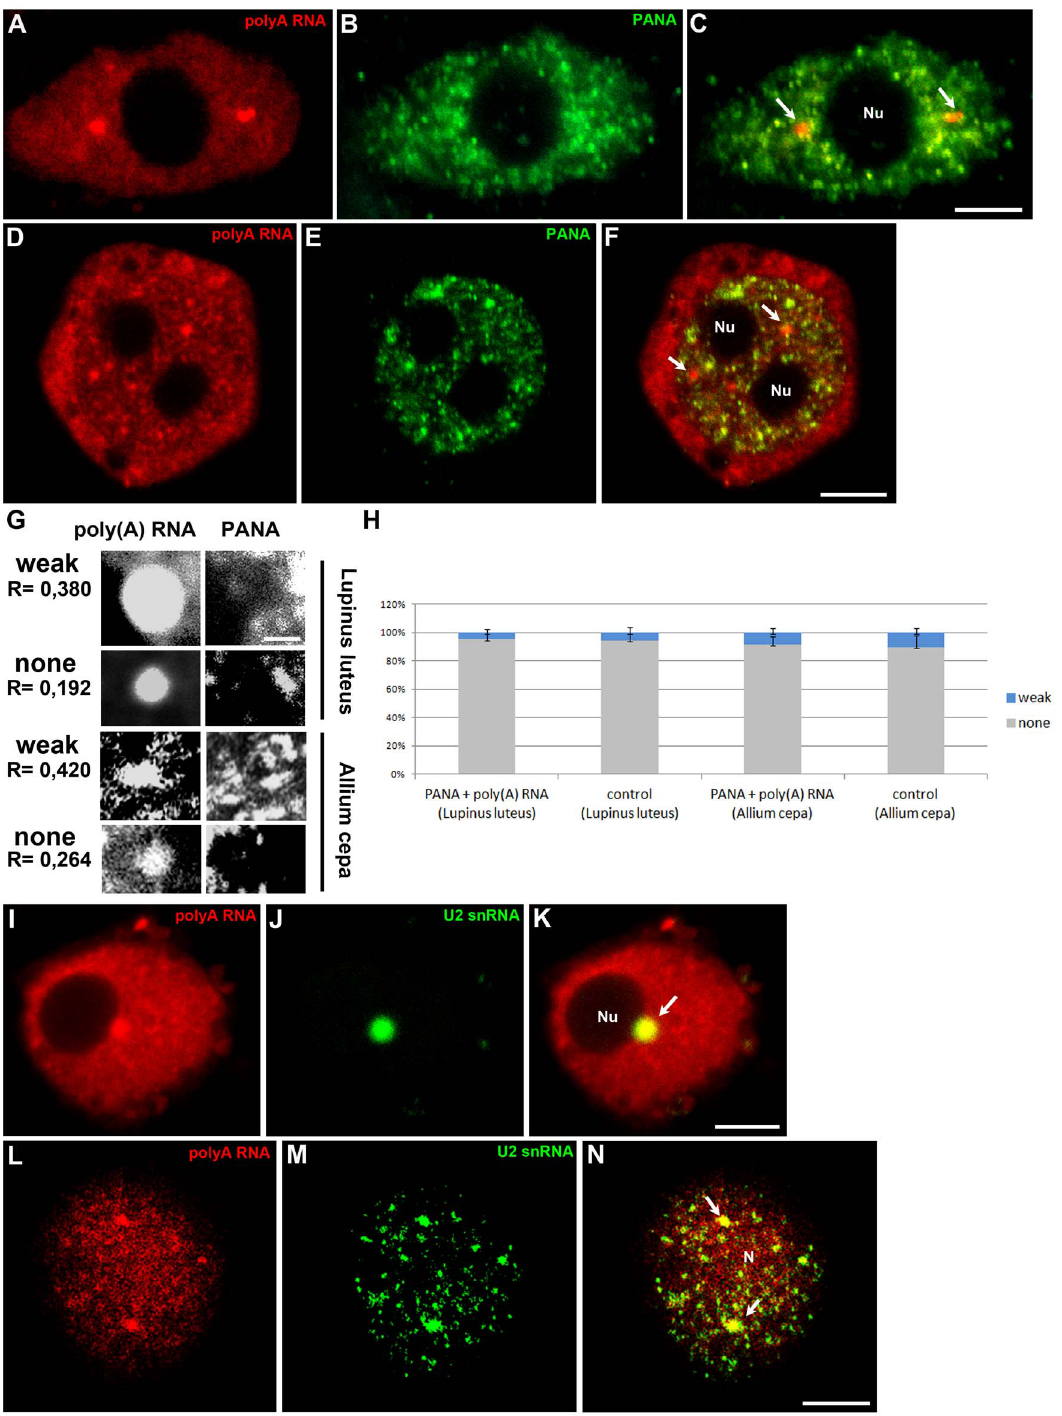
Figure 2. Double labelling of poly(A) RNA and the PANA antigen in the chromocentric ( Lupinus ) (A–C) and reticular ( Allium ) (D–F) nuclei of root cells. In the nucleoplasm of both species, poly(A) RNA is present in nuclear structures (arrows) and does not colocalise with speckles. Representative examples of Pearson correlation coefficients for weak and non-colocalisation of poly(A) mRNA with the PANA antigen in Lupinus luteus and Allium cepa cells (G). A scale bar representing 2 m m is shown. The percentages of weak and non-colocalisation of poly(A) RNA-rich bodies with the PANA antigen are indicated by the Pearson correlation coefficient (H). Error bars represent standard error. Double labelling of poly(A) RNA and U2 snRNA in Lupinus (I–K) and Allium (L–N) cells. Accumulation of poly(A) RNA in nuclear bodies rich in U2 snRNA (arrows). Bar, 5 m m. N-nucleus, Nu- nucleolus